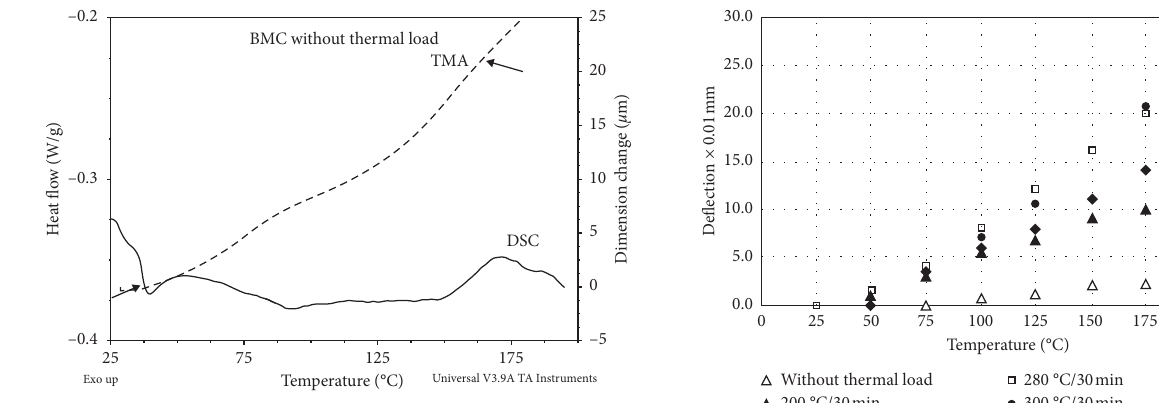
Figure 11: Comparison of DSC and TMA samples without heat exposure.